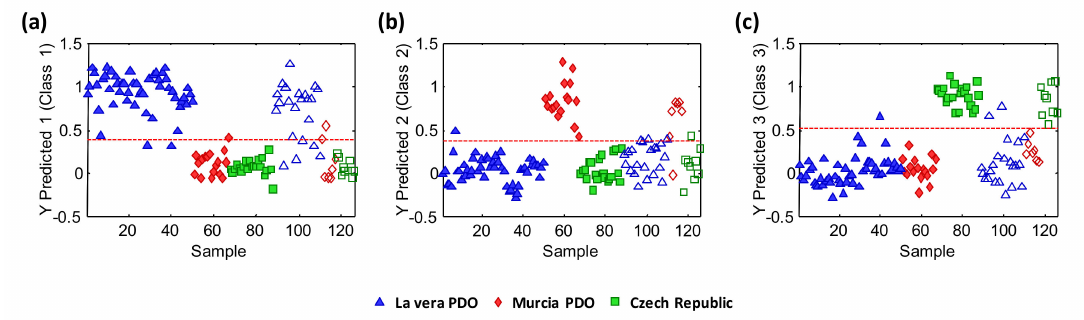
Figure 6. Partial least squares regression-discriminant analysis (PLS-DA) classification plots according to the production region. ( a ) La Vera PDO vs. other classes; ( b ) Murcia PDO vs. other classes; ( c ) the Czech Republic vs. other classes. Sample assignment: triangle = La Vera, rhombus = Murcia, and square = Czech Republic. Filled symbols = calibration set, empty symbols = validation / prediction set. The dashed line means the classification